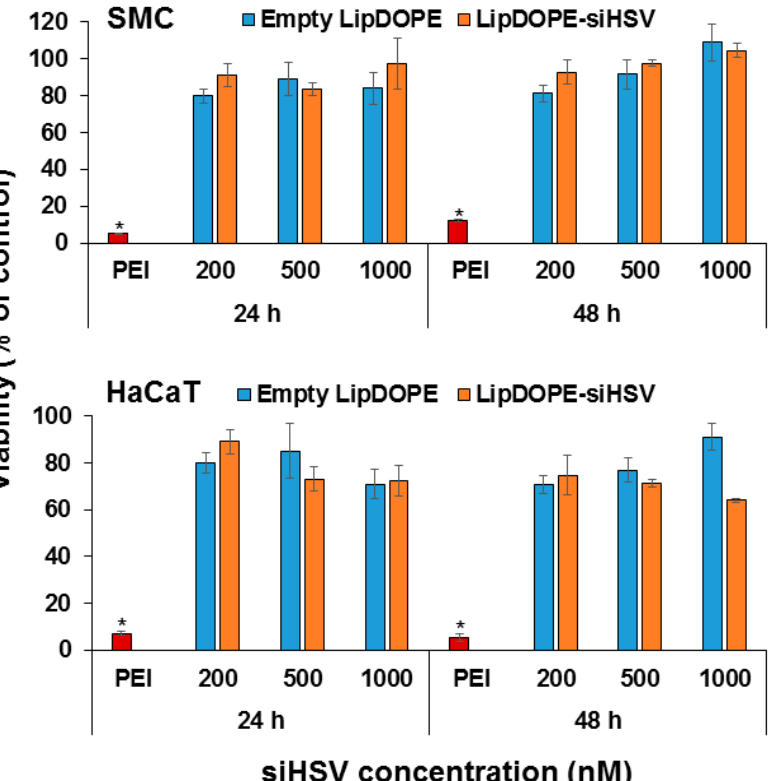
Figure 6. The dose- and time-dependent cytotoxicity of Lip DOPE -siHSV in rat primary aortic smooth muscle cells (SMC) and keratinocytes (HaCaT) cell cultures. The cytotoxicity was determined by means of the MTT assay, and cell viability was normalized to untreated cells ( n = 4; * p < 0.01).